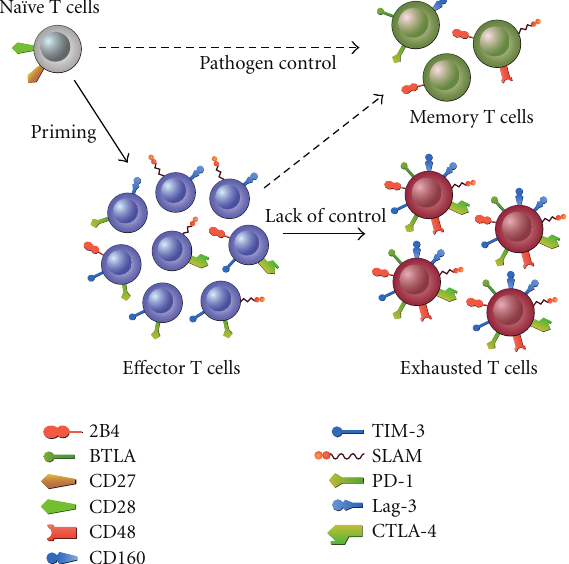
Figure 2: Expression of regulatory molecules following pathogen infection. Schematic overview of the pattern of expression of reg- ulatory molecules. Following pathogen infection, key coinhibitory molecules are upregulated with di ff erent kinetics and play a role in regulating the development and the fate of e ff ector T cells. In most cases, pathogens replication is controlled by the immune system leading to the contraction of e ff ector T cells. Many di ff erent coinhibitory molecules, that is, PD-1, CTLA-4, BTLA, SLAM,